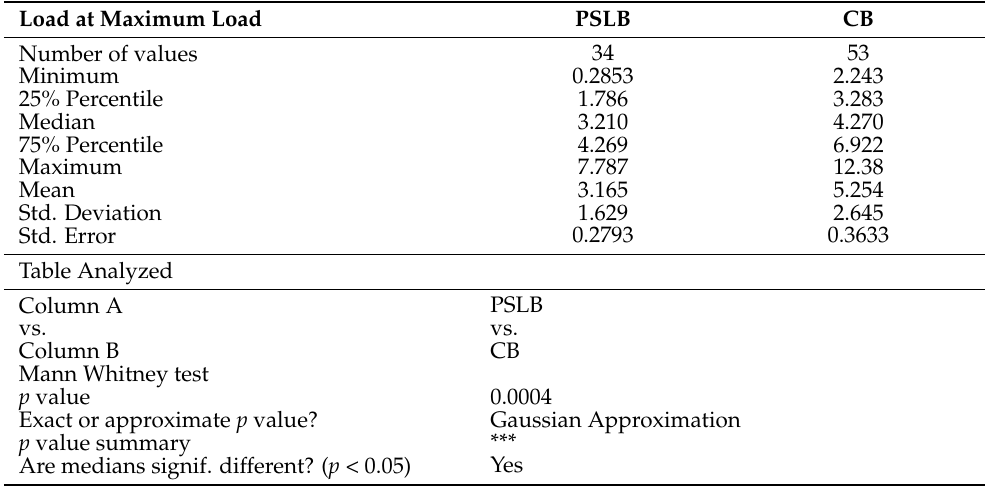
Table A8. Load at maximum load: passive self-ligating vs. conventional brackets. Load at Maximum Load Number of values